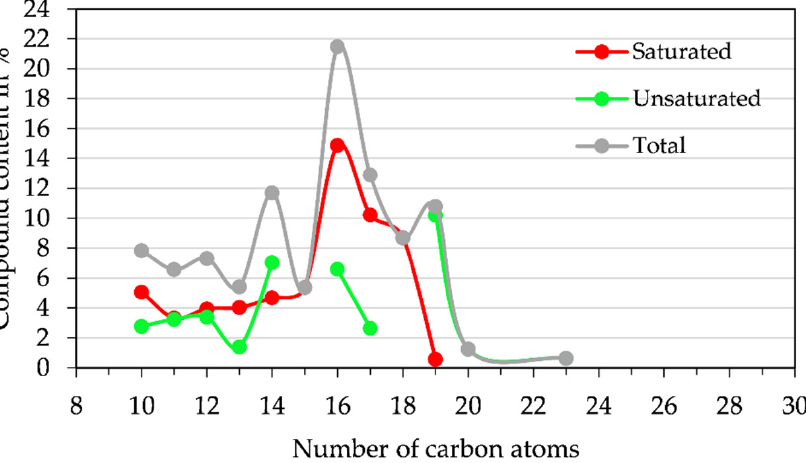
Figure 8. Percentage of compounds in HDPE pyrolysis oil and their carbon number (total compound content—grey, saturated compound content—red, unsaturated compound content—green).